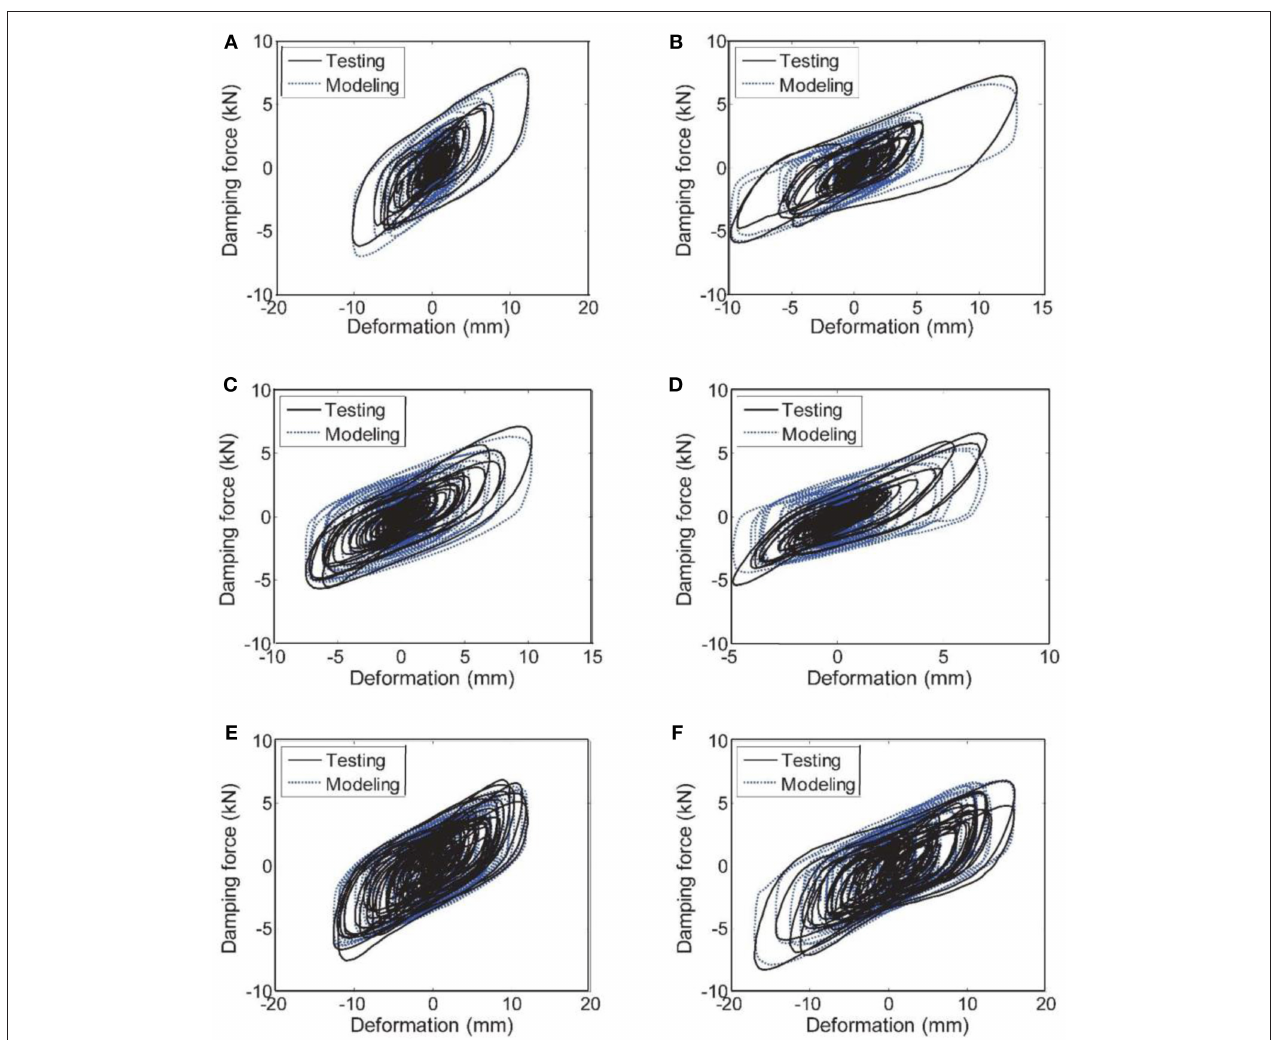
FIGURE 10 | Hysteresis curve comparison between shake table test and numerical modeling for (A) 1st floor-El Centro-0.3g, (B) 2nd floor-El Centro-0.4g, (C) 1st floor-Taft-0.3g, (D) 2nd floor-Taft-0.4g, (E) 1st floor-AW-0.3g, and (F) 2nd floor-AW-0.4g.